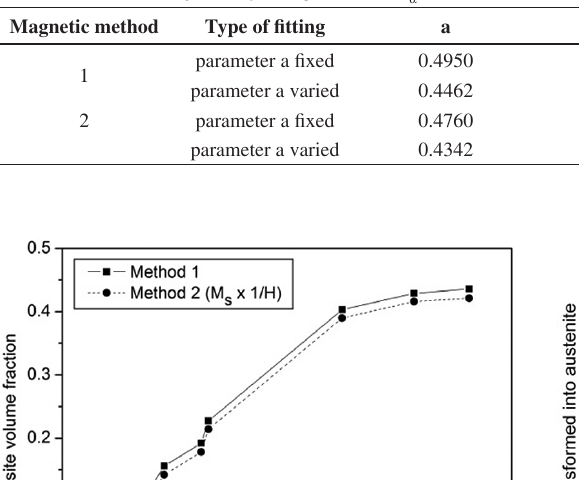
Table 5. Coefficients adjusted by fitting curves of C